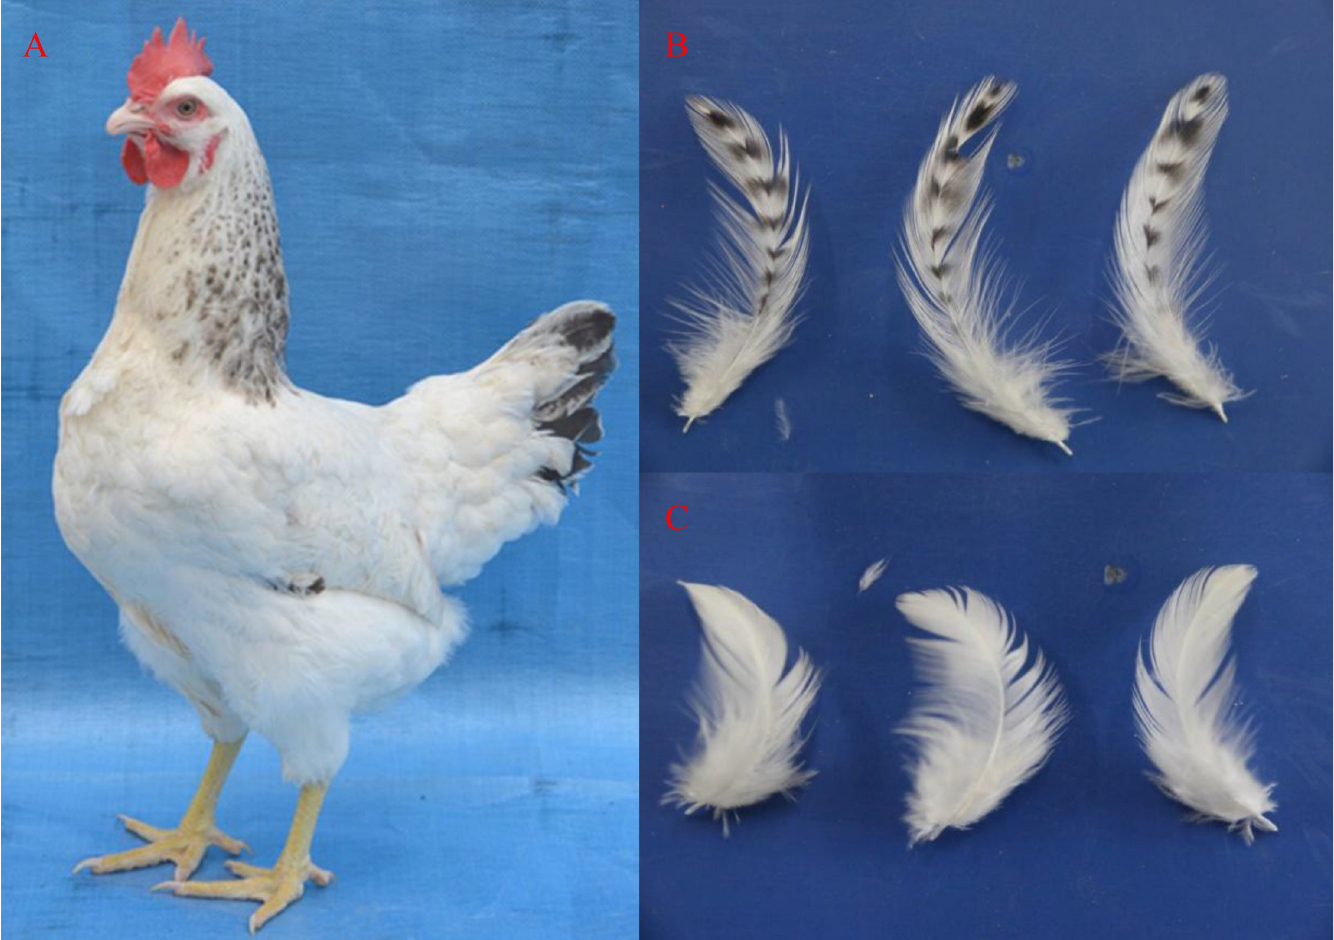
Fig 1. “Yufen I” H line chicken and the feather bulbs used in this study. ( A). “Yufen I” H line chicken, (B). black and white striped-feathers in the dorsal neck, (C). white feathers in the ventral neck.